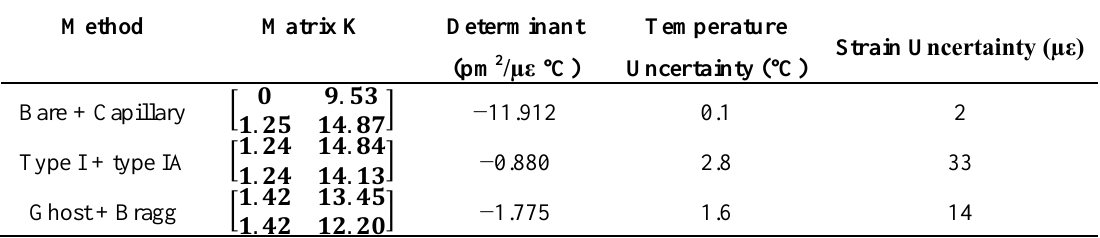
Table 2. Comparison of performances between the three investigated solutions for temperature-strain